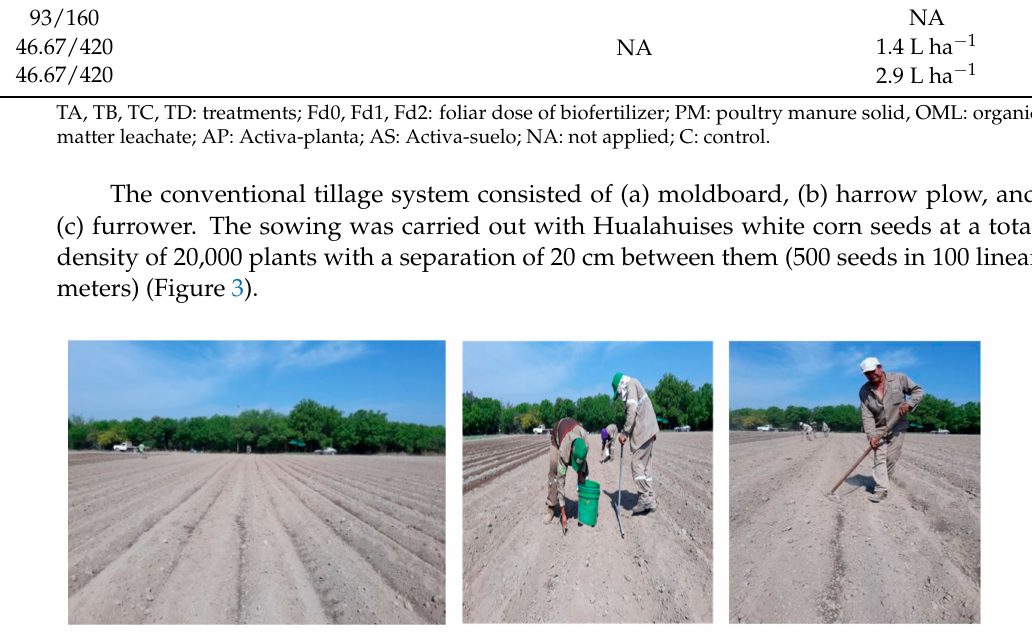
Figure 3. Corn sowing and poultry manure